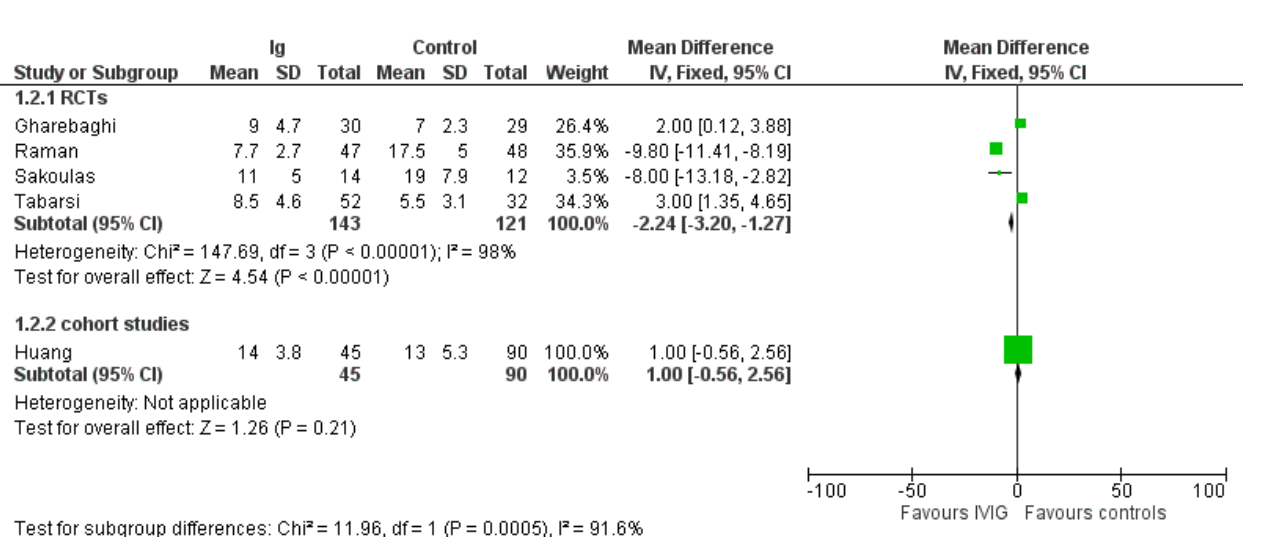
Vaccines 2022 , 10 , x FOR PEER REVIEW Figure 2. Forest plot of mortality. Figure 2. Forest plot of mortality.